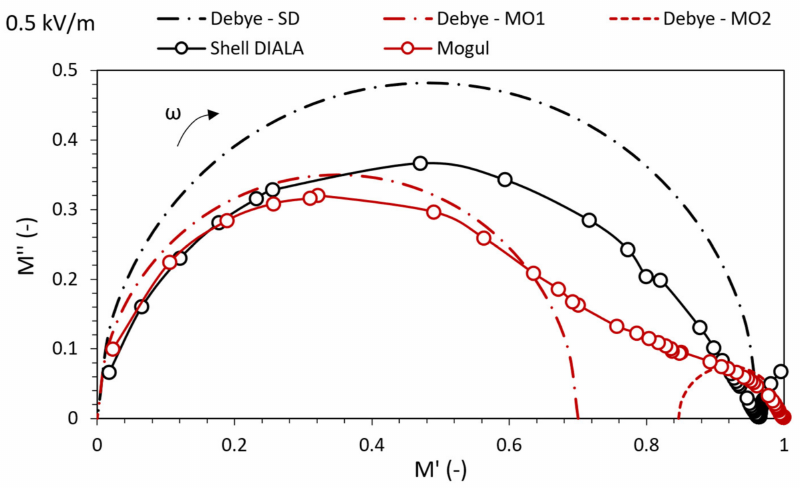
Figure 7. Comparison of electrical insulating oils of the intensity E of time-varying electric field 0.5